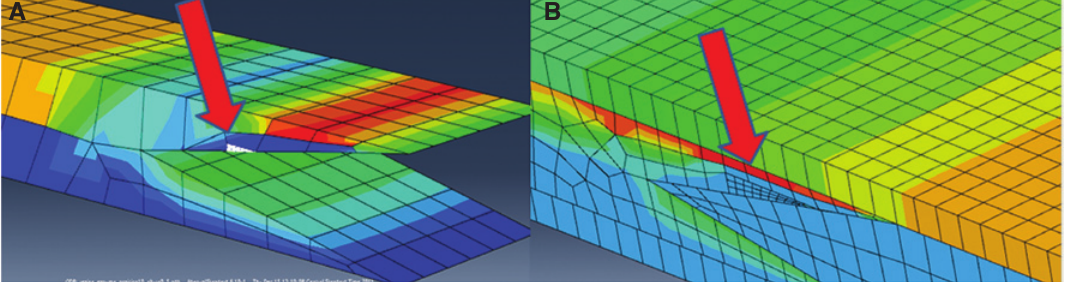
Figure 8 FEA of sandwich beam with resin epoxy in the foam-skin interface.